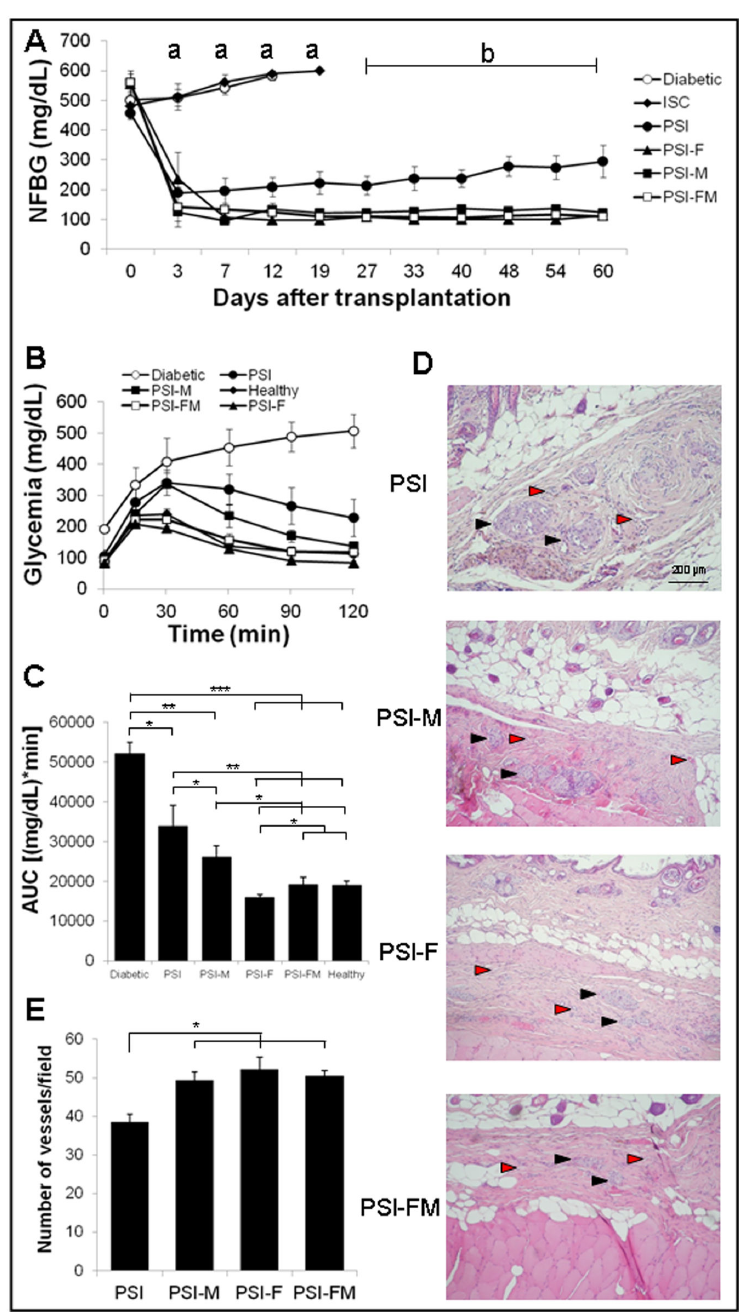
Figure 1. Subcutaneous transplantation of PSI in immunodeficient diabetic mice. A) Follow up of NFBG in the following groups: (○) non-transplanted mice; (♦) mice subcutaneously transplanted with free islets (ISC); (●) mice subcutaneously transplanted with PSI; (■) mice subcutaneously transplanted with PSI containing 2x10 5 allogenic BM-MSCs (PSI-M); (▲) mice subcutaneously transplanted with PSI containing 2x10 5 autologous fibroblasts (PSI-F); (□) mice subcutaneously transplanted with PSI containing 2x10 5 of both autologous fibroblasts and allogenic BM-MSCs (PSI-FM). B) Blood glucose responses to IPGTTs, 60 days after transplantation. Groups are the same as detailed in A except for (◊) non-transplanted healthy mice. C) AUC data obtained from IPGTTs. D) Histology of subcutaneous islet xenografts 60 days after transplantation in hematoxylin and eosin stained samples. Black arrows point to islets and red arrows point to vessels. E) Quantification of vessels in the subcutaneous grafts after CD31 immunostaining. For all groups n=5. Statistical significances (p<0.05): ( a ) ISC and diabetic vs the other groups; PSI vs PSI-M, PSI-F and PSI-FM; ( b ) PSI vs PSI-M, PSI-F and PSI-FM. (*) p<0.05; (**) p<0.01. doi: 10.1371/journal.pone.0073526.g001 PLOS ONE |